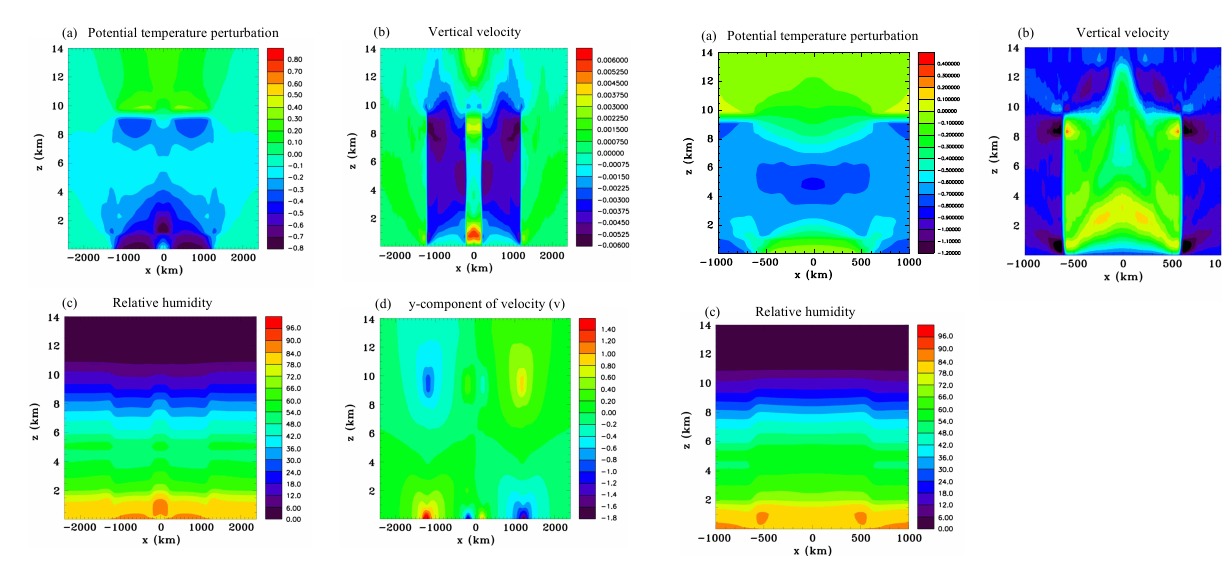
Figure 7. Vertical sections for Experiment 6: the wide unforced re- gion case, at t = 12h. (a) Potential temperature perturbation (K), (b) vertical velocity (ms − 1 ), and (c) relative